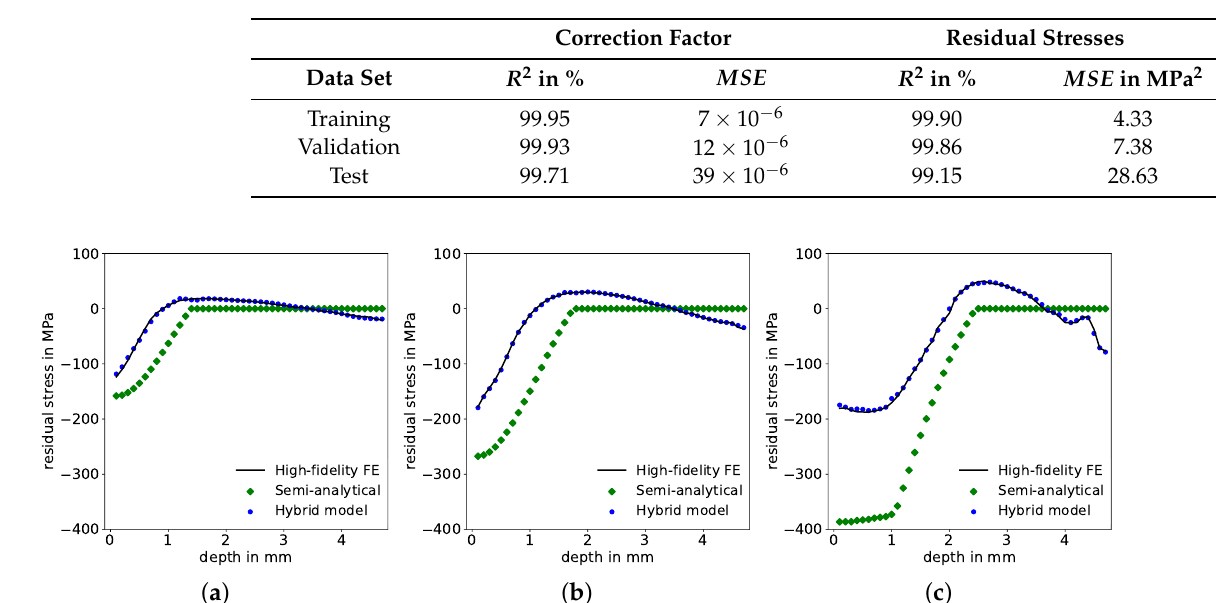
Figure 9. ( a ) Learning curves: MSE-loss function values on training and validation data sets over number of epochs during training and ( b ) corresponding prediction values of the correction factor versus true values, and of ( c ) the corresponding residual stresses. Table 4. Prediction metrics of the trained ANN via Approach 2: Determination coefficient R 2 and MSE for correction coefficients as well as corresponding residual stresses achieved on training, validation and test data sets, respectively.